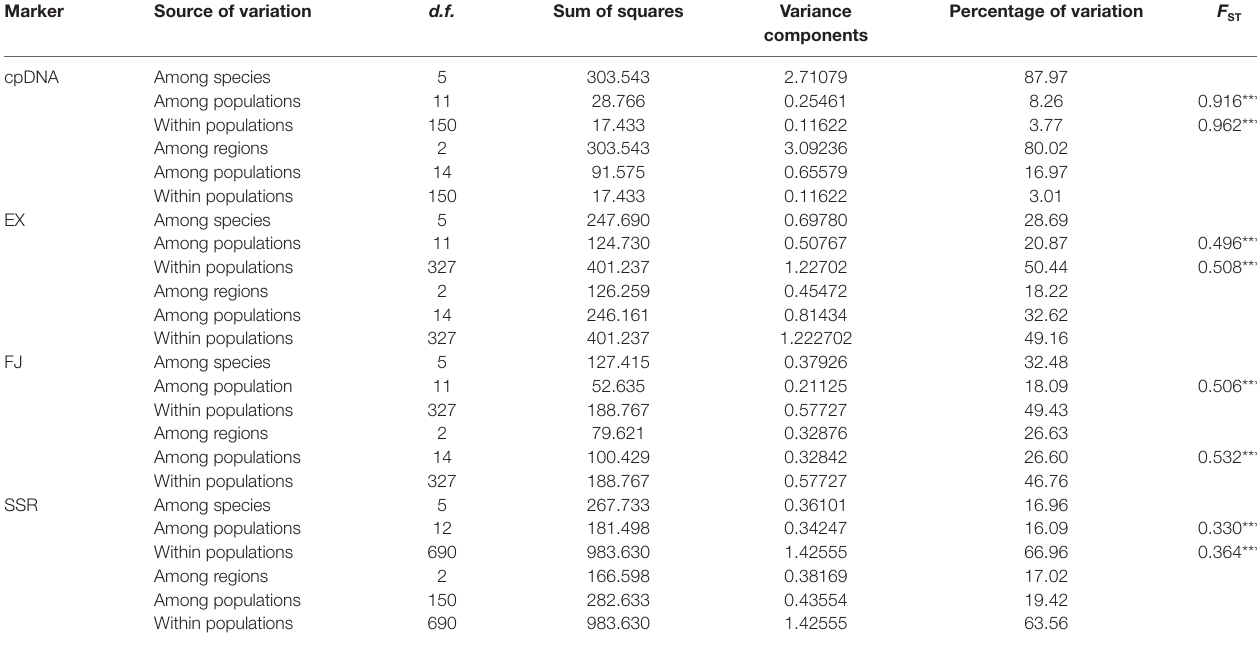
TABlE 3 | Analysis of molecular variance (AMOVA) of the Cycas taiwaniana complex based on chloroplast DNA (cpDNA), single-copy nuclear genes (SCNGs), and microsatellites.